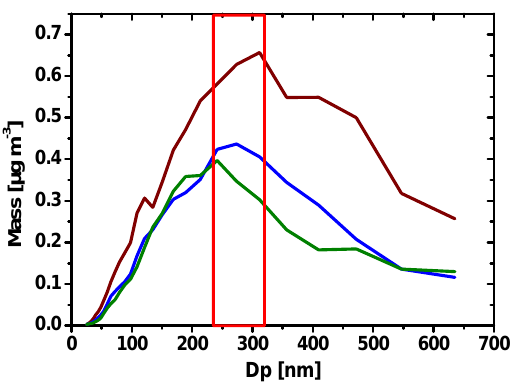
Fig. 7. Mass size distributions of humidified samples at an RH of 90% for a sample day during the summer campaign. Figure 7. Mass size distributions of humidified samples at an RH of 90 % for a sample day 3 during the summer campaign. 4 Table 2. Measured growth factors on average during summer and winter for 55%, 75%, and 90% relative